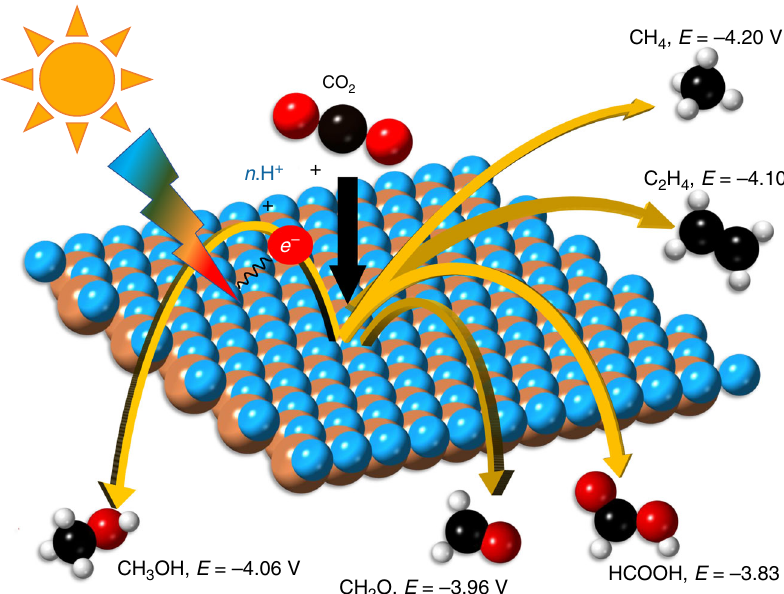
Fig. 1 A schematic of photocatalytic reduction of CO 2 to chemical fuels. Light of suf fi cient energy can excite electrons across the bandgap of a photocatalyst which can be used to drive the reaction of CO 2 with hydrogen ions to several closely competing products. At a neutral pH the potential required for converting to each product is noted. The potential for H + /H 2 at this pH is − 4.03 eV 63 with respect to the vacuum